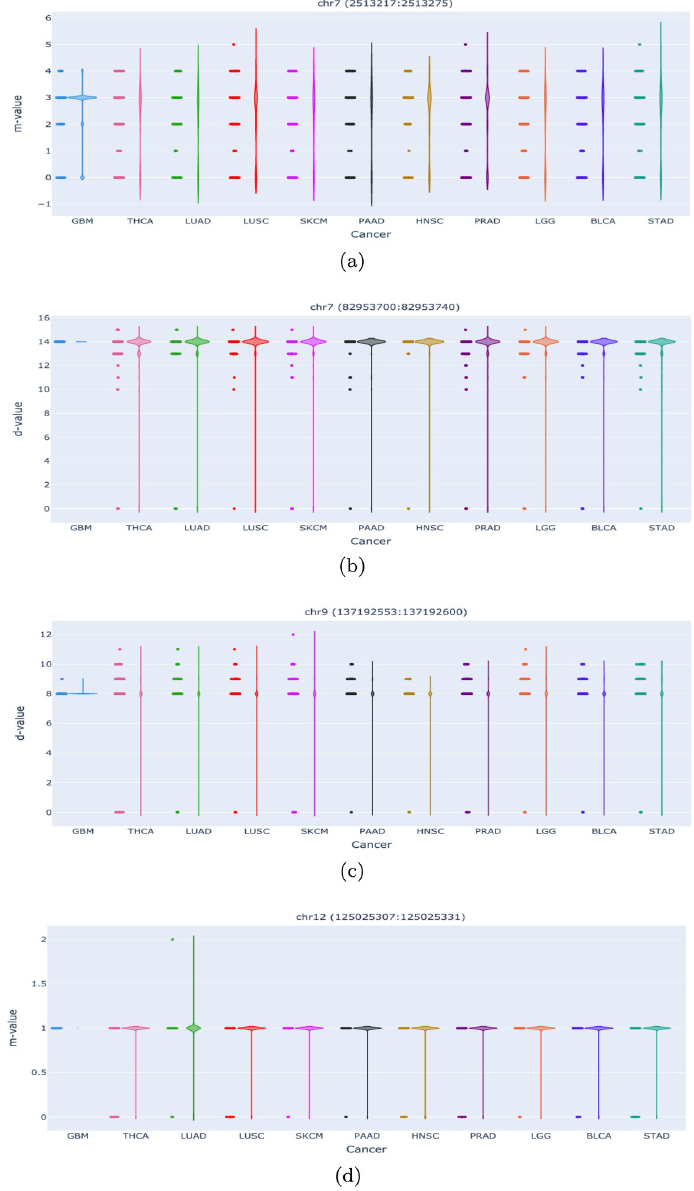
Fig 2. Distinctive tandem repeat region mutation histories. Violin plots representing the distribution of m or d in tandem repeat regions in the DNA derived from blood cells for patients with different cancer types. These tandem repeat regions show distinctive distributions of m or d values in GBM patients compared to others leading to a differentiating signature (mutation histories) which is extracted from the DNA of blood-derived cell for GBM patients. An interactive version of these plots is provided at the following links (a), (b), (c), (d).